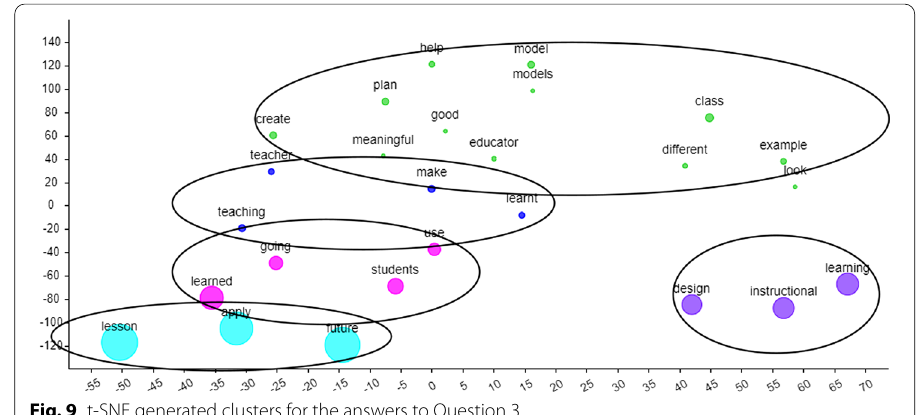
Fig. 9 t-SNE generated clusters for the answers to Question 3